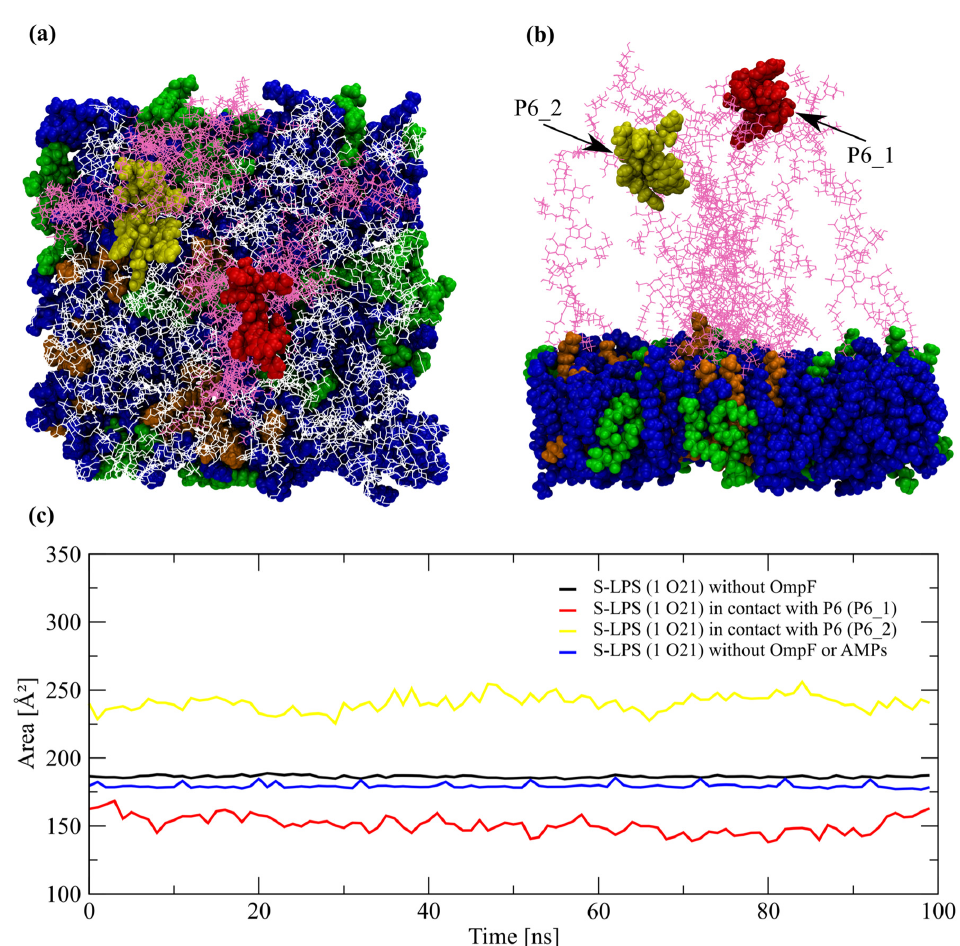
Figure 5. Graphical representation of two P6 peptide molecules inserted in a S-LPS E. Coli membrane model without the OmpF monomer: ( a ) top view and ( b ) side view. LPS chains in contact with the two P6 molecules are colored in mauve, while the rest are colored in white, PPPE are colored in blue, PVPG are colored in green, PVCL2 are colored in orange. ( c ) APL-like analysis of regions of the LPS layer interacting with P6 peptide, one with relatively higher density of O-antigen molecules (P6_1) and a second with relatively lower density of O-antigen molecules (P6_2).